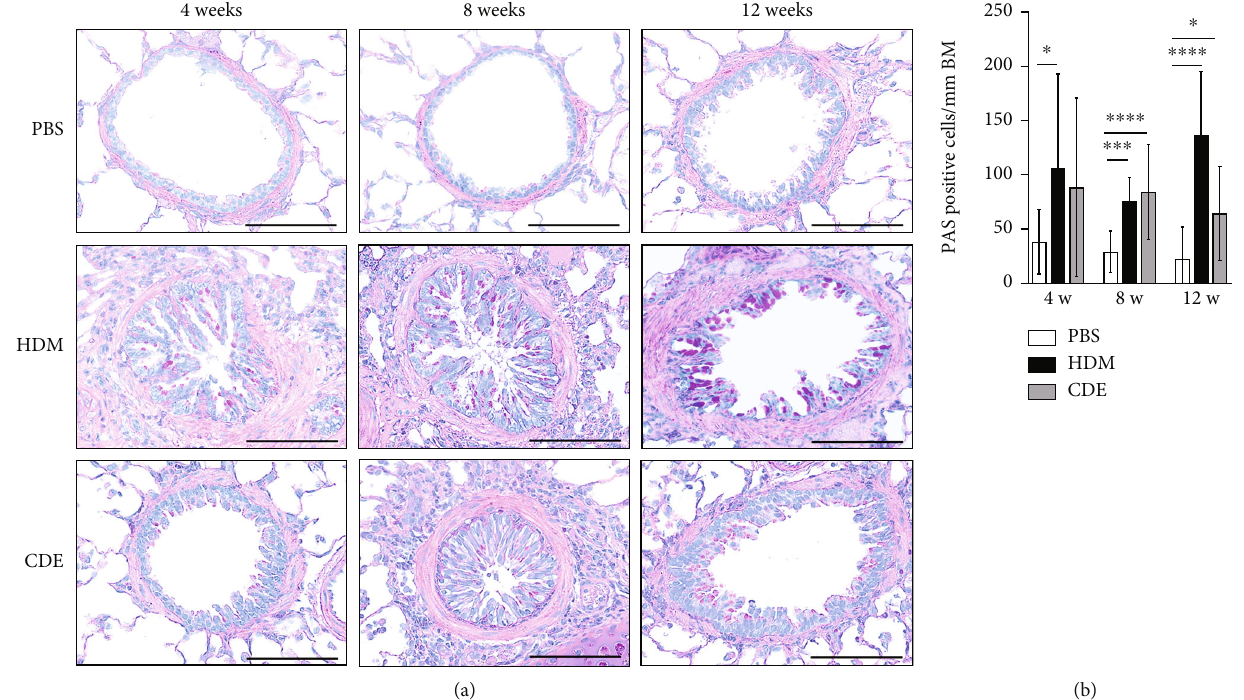
Figure 4: Guinea pigs exposed to HDM and CDE exhibit goblet cell hyperplasia in the airways. (a) Representative histological sections of PAS-stained lungs and (b) quanti fi cation of goblet cells expressed as cell number/BM perimeter (mm). Data are mean ± SD of n = 4 -5 animals per group. Scale bars correspond to 100 μ m. ∗ P < 0 : 05 , ∗∗∗ P < 0 : 001 , and ∗∗∗∗ P < 0 : 0001 . BM: basement membrane; HDM: house dust mite extract; CDE: cat dander